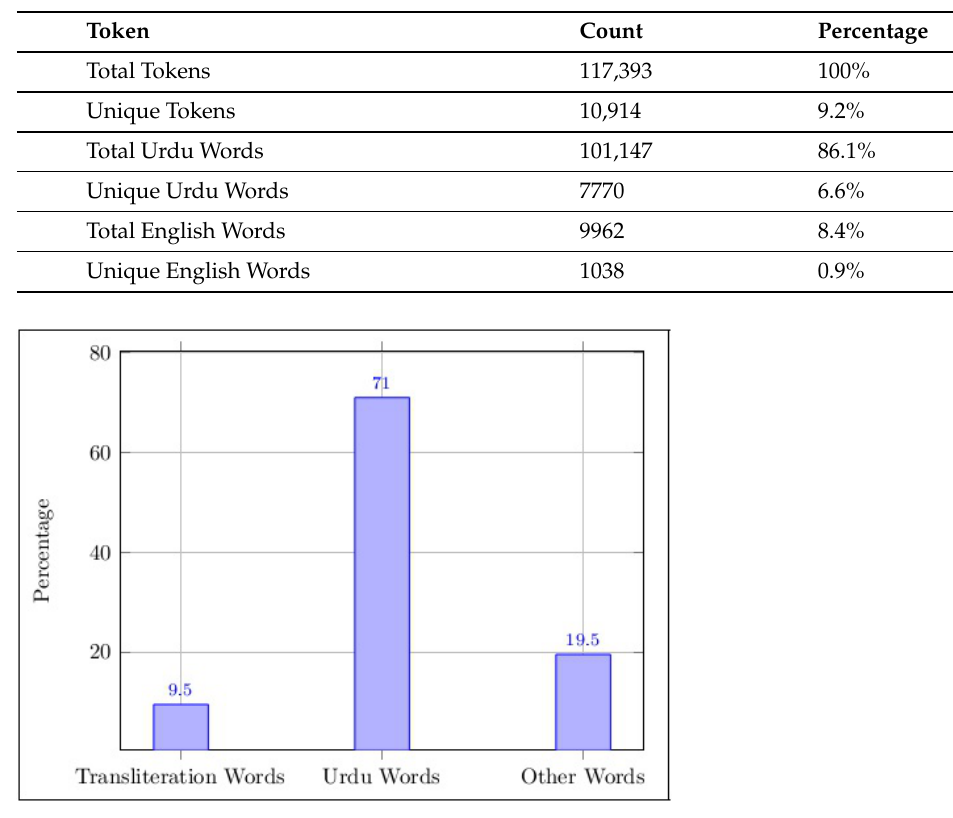
Table 2. Tokens Distribution in 600 News Articles Corpus.